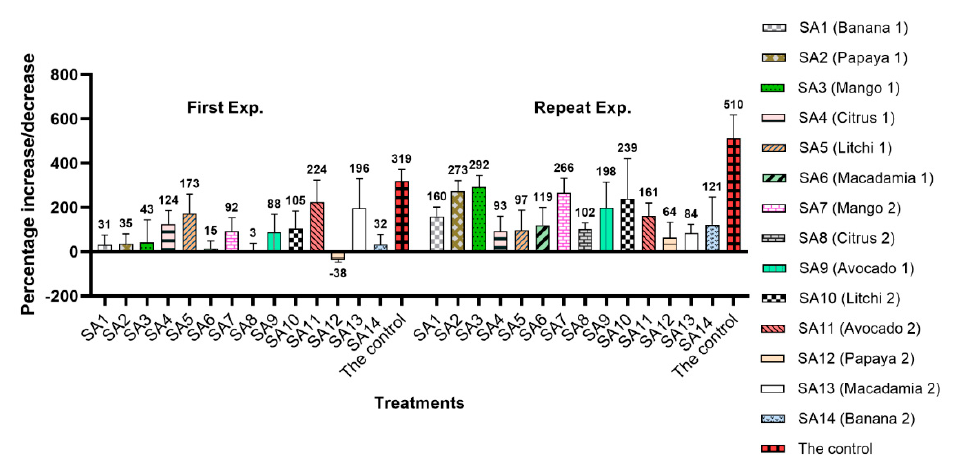
Figure 3. Nematode suppression effect of microbial communities associated the rhizosphere of various tropical fruit trees inoculated to roots of tomato (Moneymaker), 7 weeks post-inoculation with 2000 eggs and second-stage juveniles of Meloidogyne enterolobii . The Y -axis shows the percentage, among which, positive numbers show the increase and negative numbers indicate a reduction in the initial nematode population.